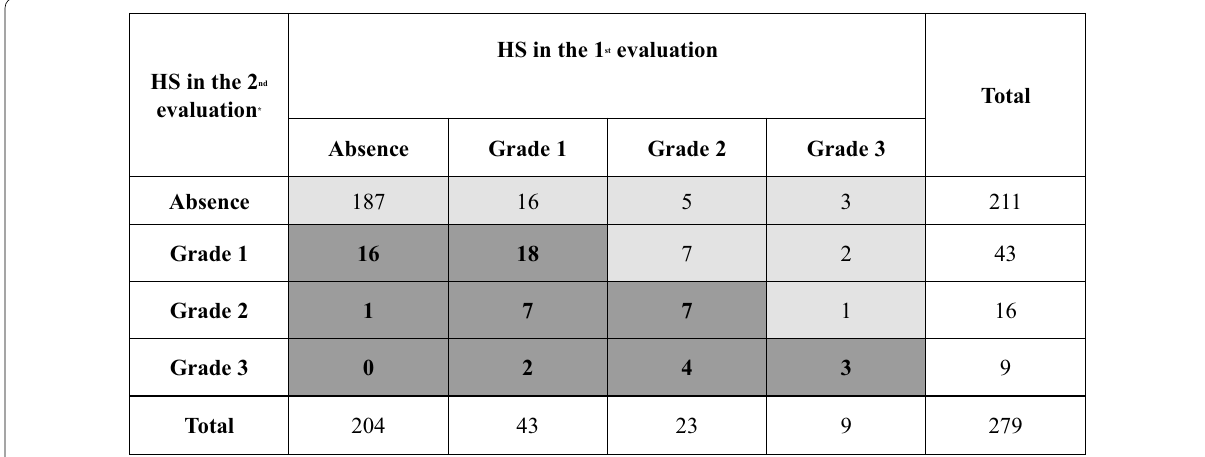
221): they had not and continued without = 58): They had not and started to have or did not change/ =